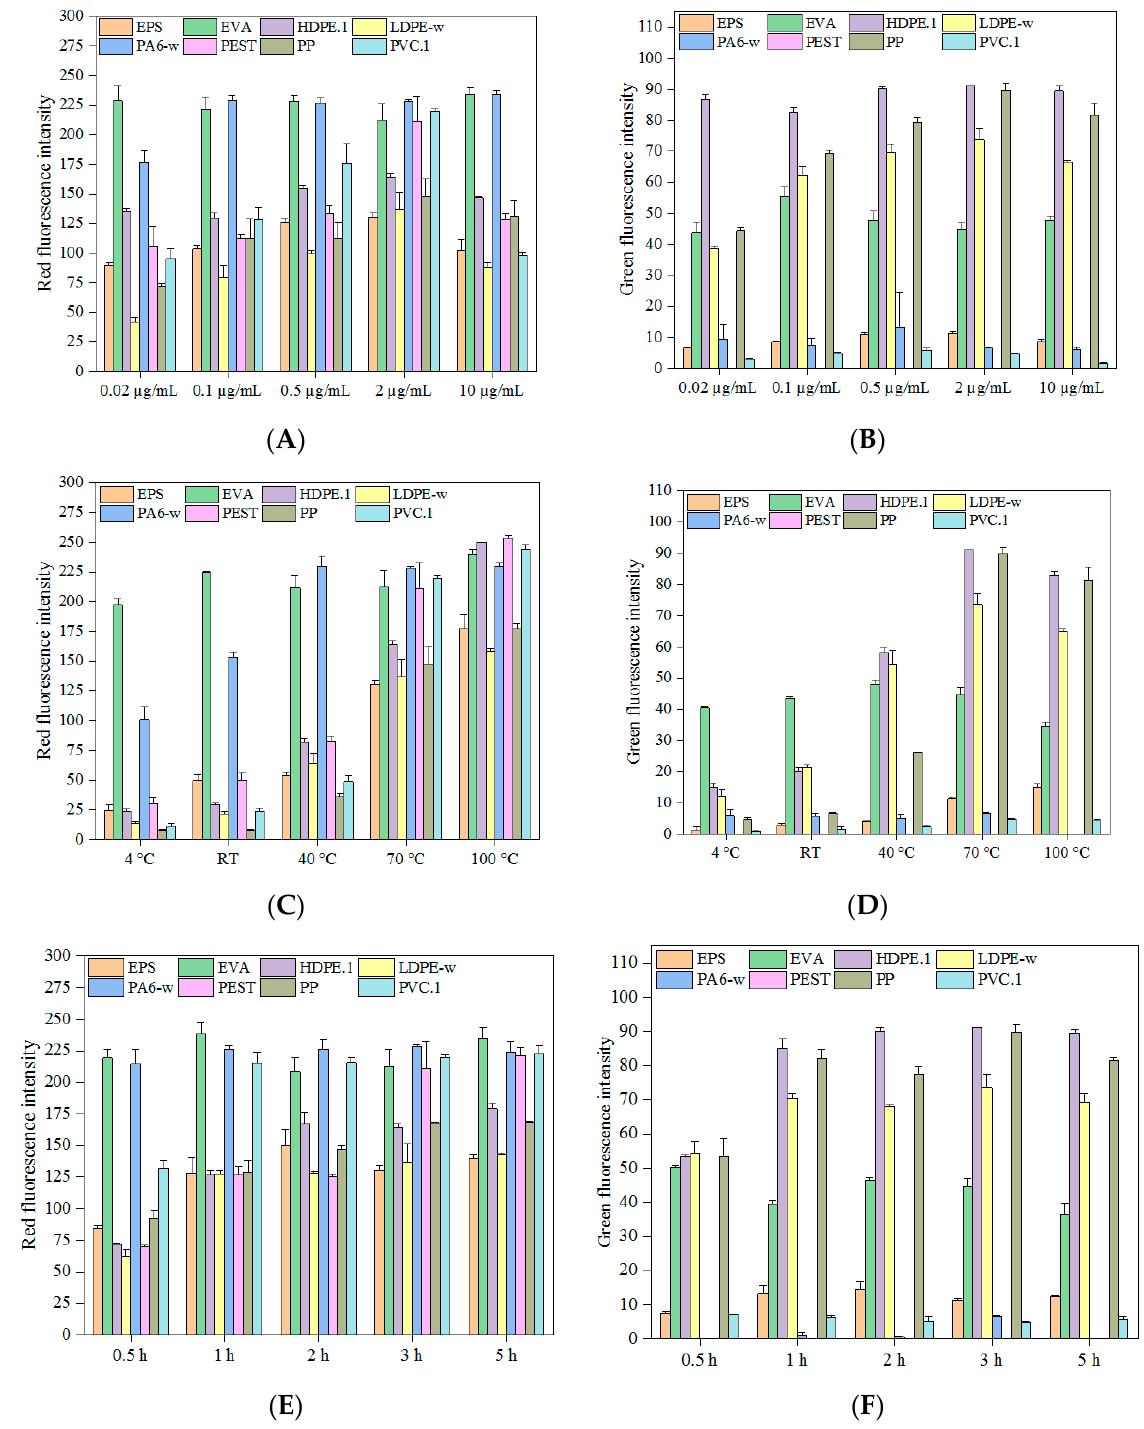
Figure 1. The influence of ( A , B ) concentrations of Nile red at 70 ◦ C for 3 h, ( C , D ) temperatures at the Nile red concentration of 2 µ g/mL for 3 h, and ( E , F ) time at the Nile red concentration of 2 µ g/mL at 70 ◦ C on microplastic staining.